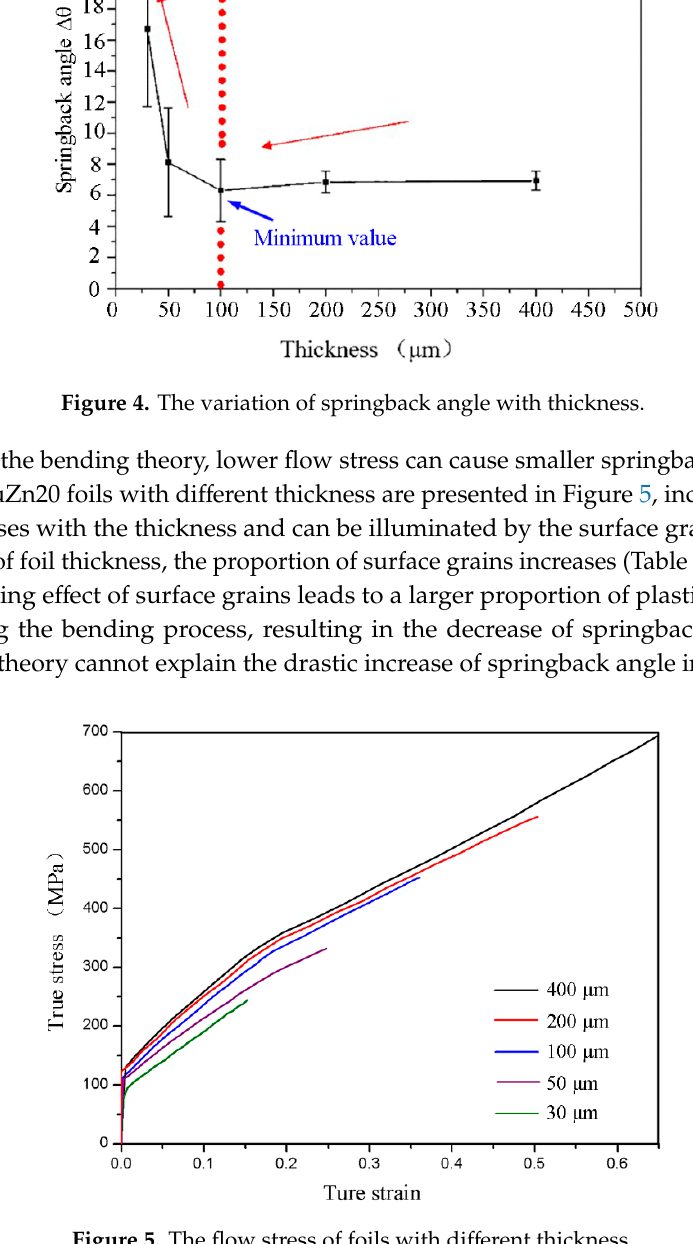
Figure 5. The flow stress of foils with di ff erent thickness.